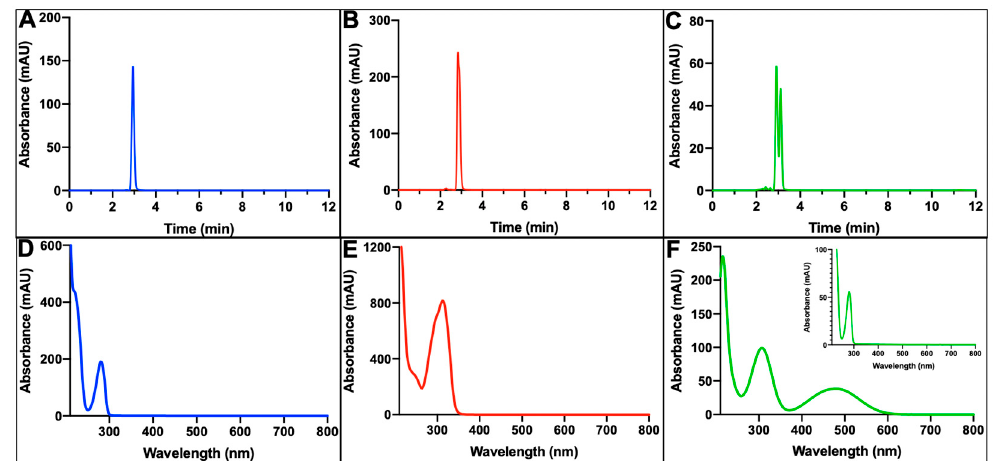
Figure 7. L-DOPA, DHICA, and native dopachrome are identified through HPLC. ( A ) The standard of L-DOPA (1.5 mM) has a retention time of 2.939 ± 0.024 min. ( B ) The standard of DHICA (1.5 mM) has a retention time of 2.864 ± 0.054 min. ( C ) The sample of native dopachrome was eluted with two retention times at 2.913 ± 0.024 min and 3.110 ± 0.027 min. ( D ) The peak at 2.939 retention time has an absorbance spectrum with a peak at 280 nm. ( E ) The peak at 2.864 retention time has an absorbance spectrum with a peak at 315 nm. ( F ) The peak at 2.913 retention time has an absorbance spectrum with a peak at 280 nm (seen in the insert). The peak at 3.110 retention time has an absorbance spectrum with peaks at 310 and 475 nm.